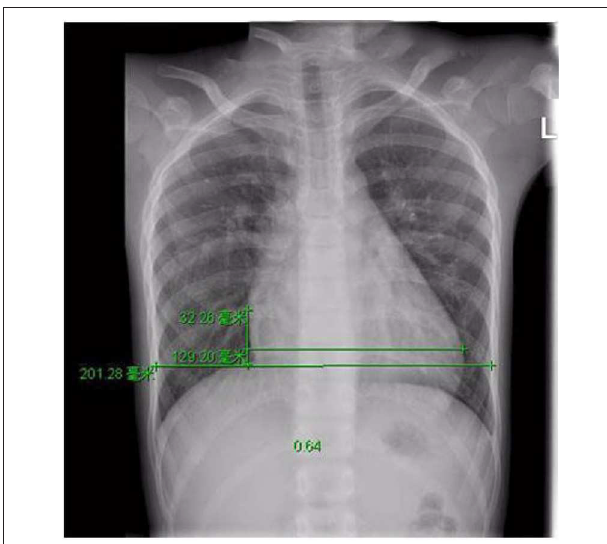
FIGURE 1 | Pre-operative Chest X-ray film view showed increased pulmonary flow and cardiomegaly, with a cardiothoracic area ratio of 0.64. malformations (4–6). The left circumflex artery (LCX) fistula is